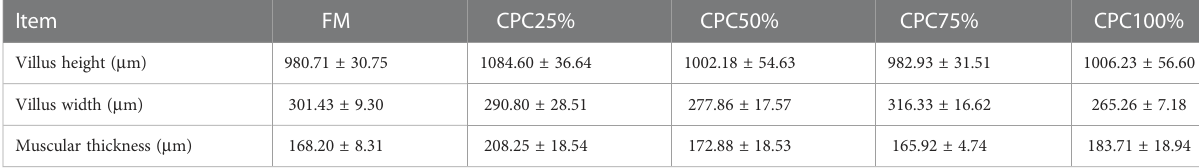
TABLE 10 Effects of fi shmeal replacement by cottonseed protein concentrate on histology of proximal intestine in rainbow trout (Mean ± S.E.).